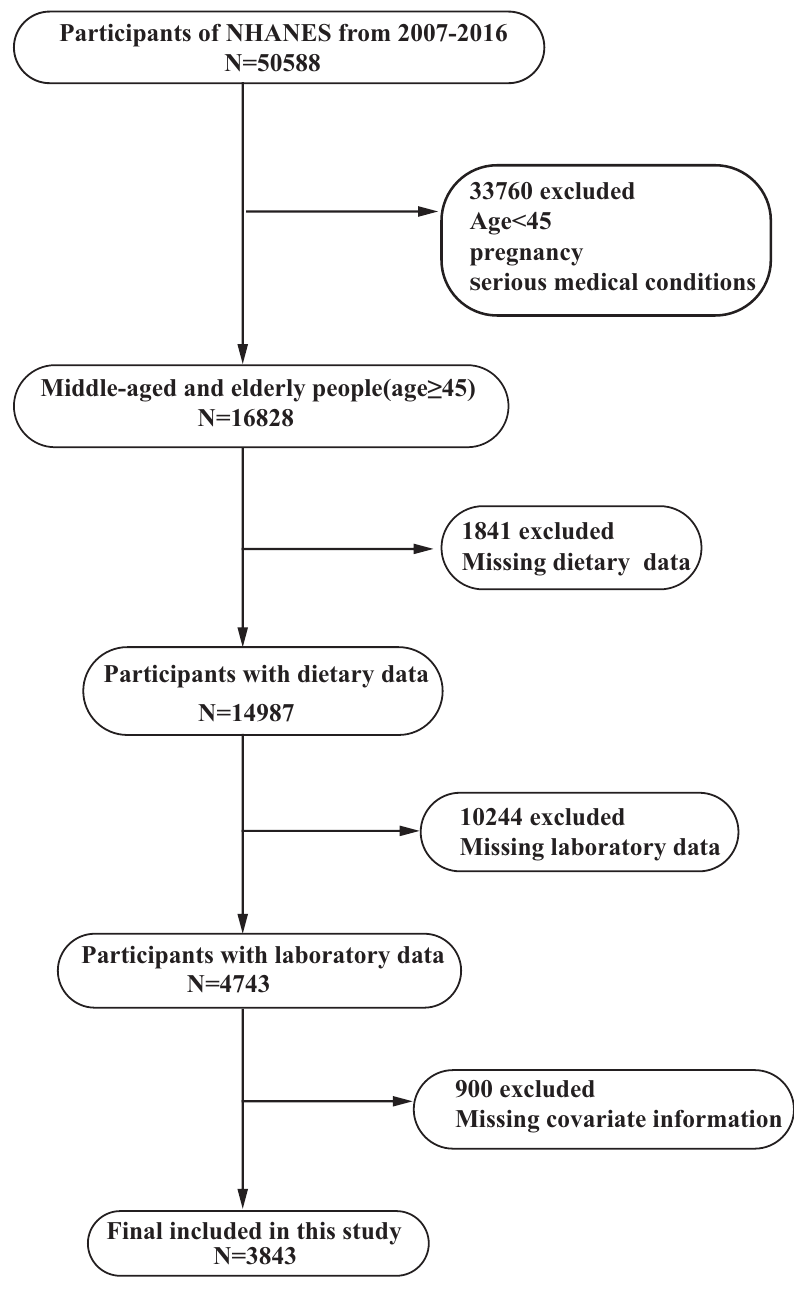
Figure 1. Flow diagram of participants in the